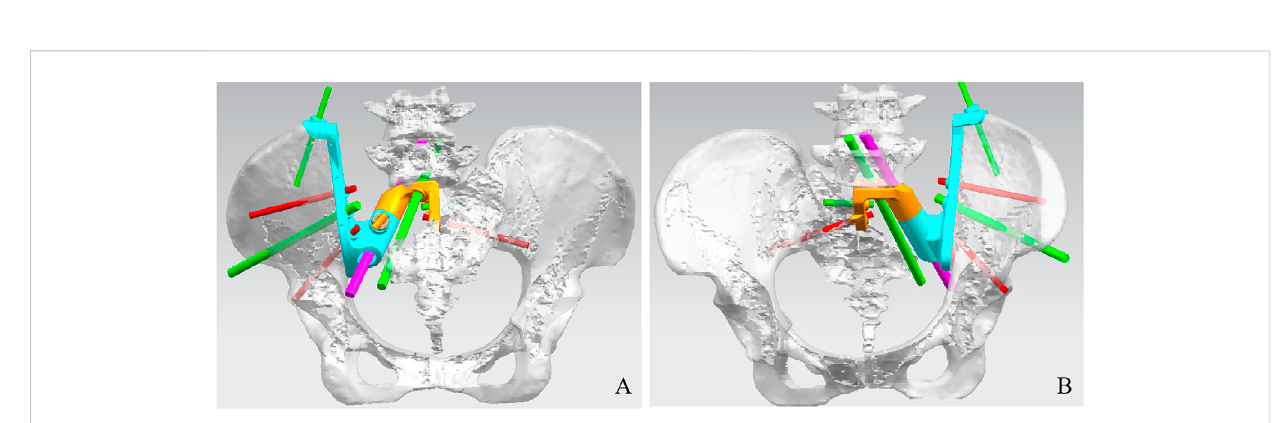
FIGURE 2 Design of the sacral implant. Dorsal view (A) and front view (B) of the sacral implant 3D